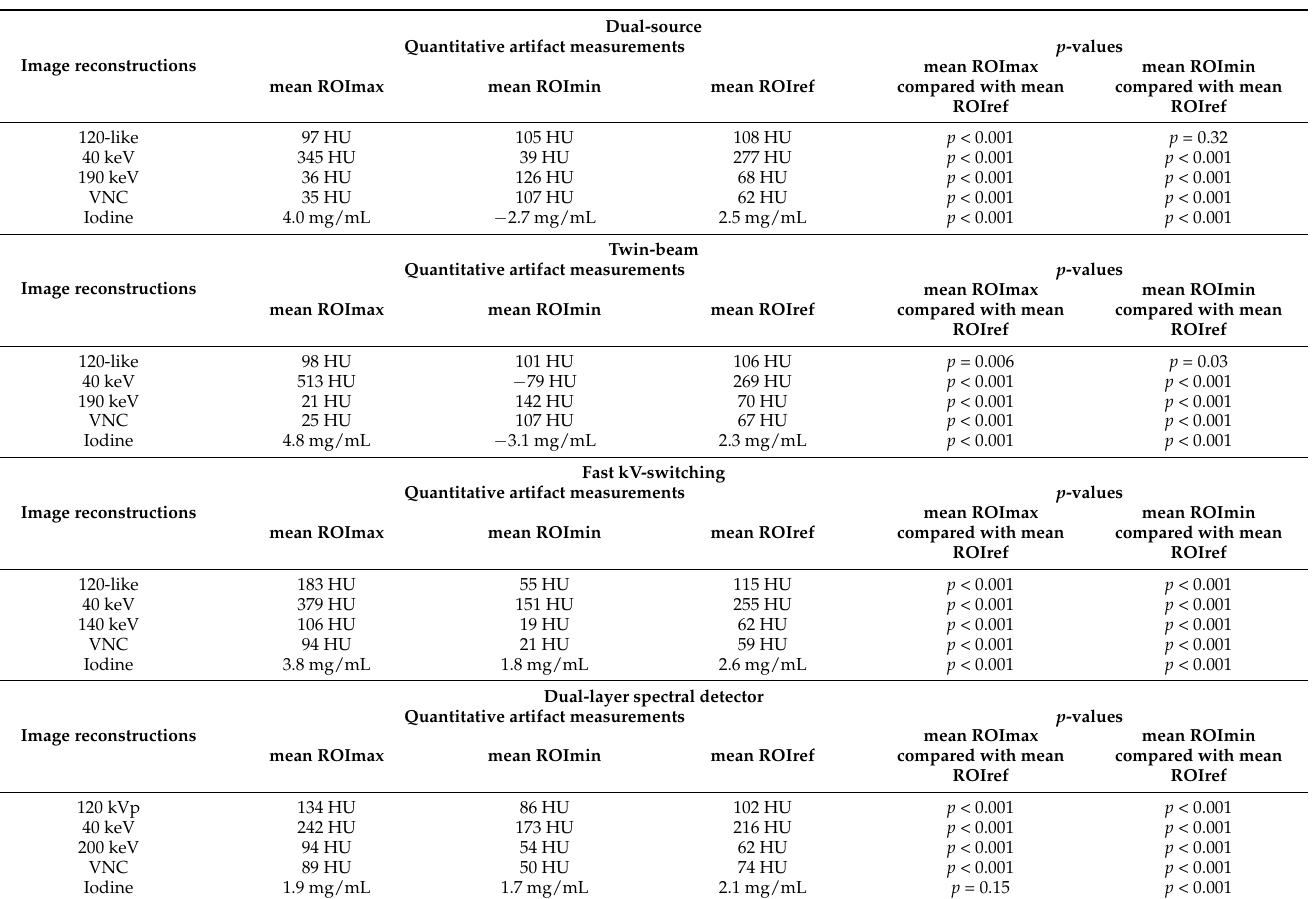
Table 2. Quantitative measurements of visceral-motion-related artifacts on the liver in 120-kVp(-like), low- and high-keV, VNC, and iodine images acquired on a dual-source, twin-beam, fast kV-switching, and dual-layer spectral detector DECT scanner. ROImax (regions of interest measurement in the most visible area and on the low-keV bright area of the artifact). ROImin (regions of interest measurement in the most visible area and on the low-keV dark area of the artifact). ROIref (regions of interest measurement in neighboring, unaffected liver